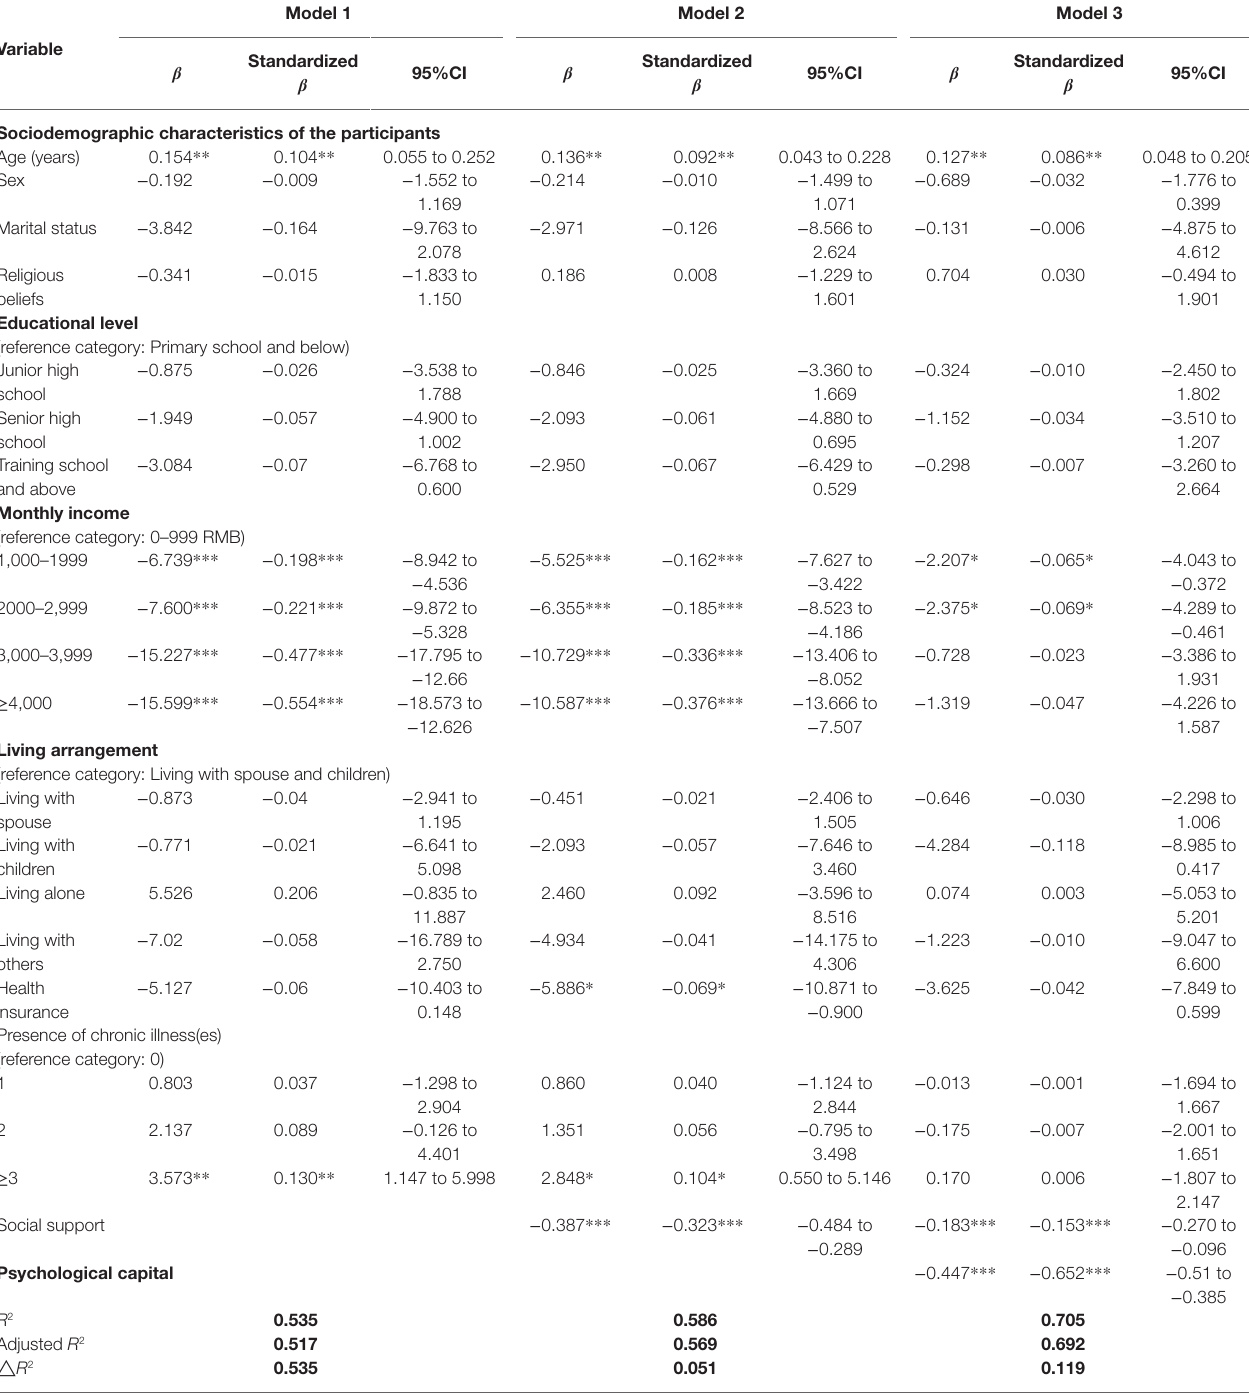
TABLE 3 | The hierarchical multiple regression analysis of elder self-neglect (N =